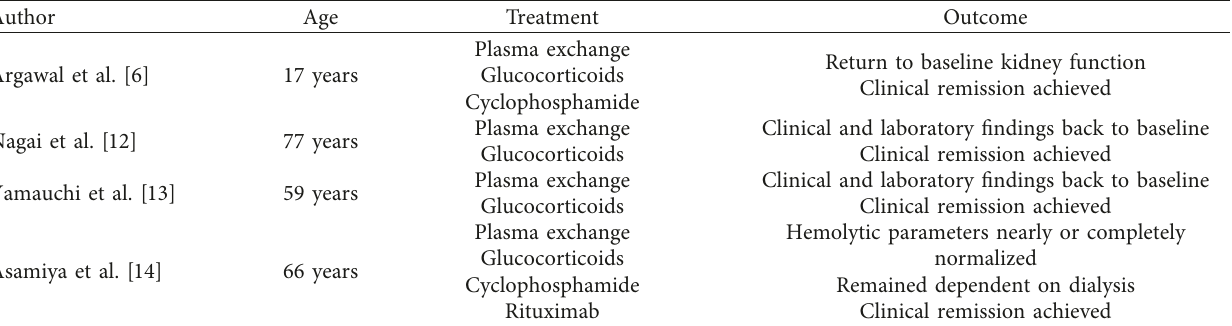
Table 5: TTP and vasculitis treatments and